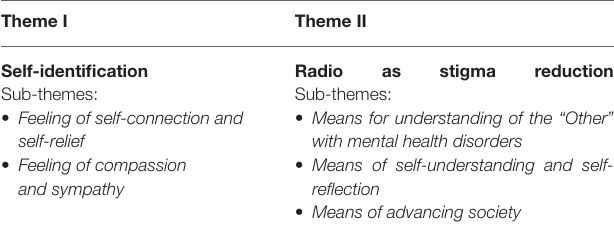
TABLE 2 | Themes emerged from audience participants testimonies on radio program. Theme